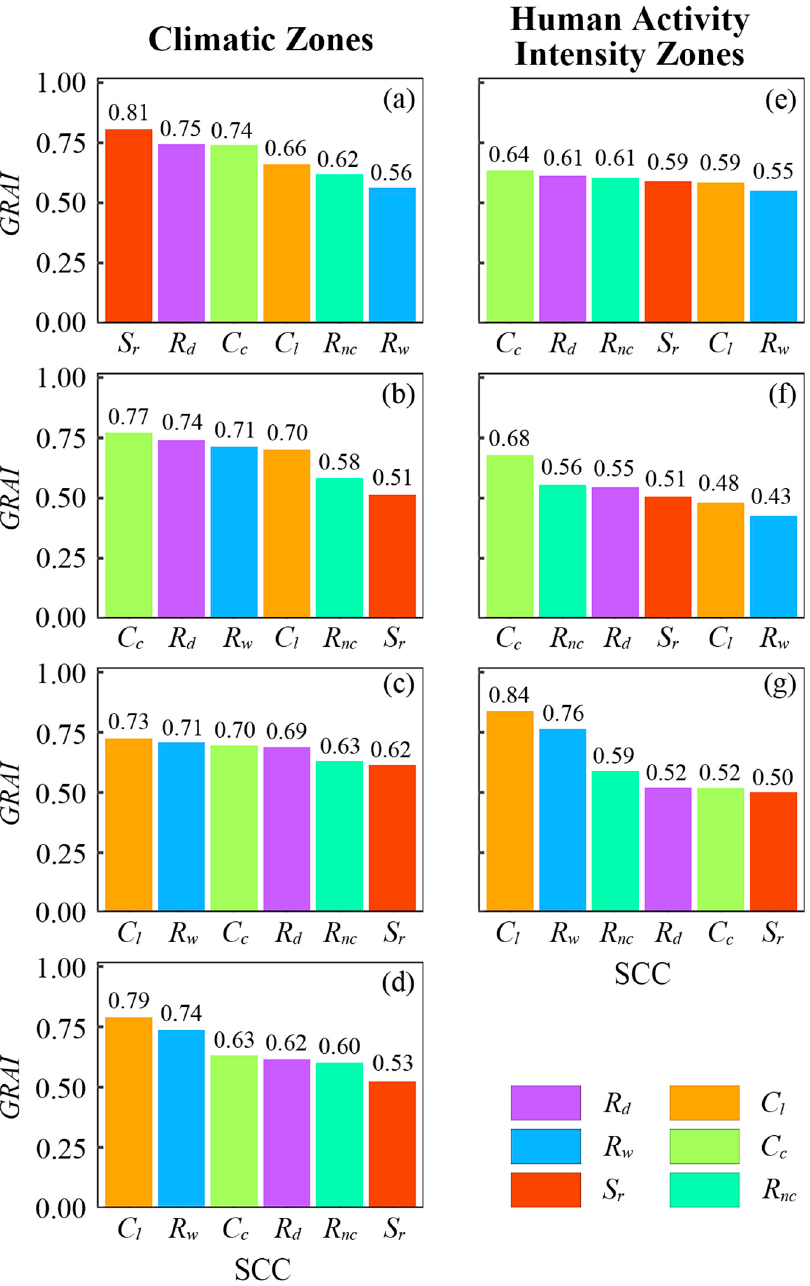
Figure 6. Plots illustrating the grey relational degree index ( GRAI ) in different climatic zones (left panel) and human activity intensity zones (right panel). The subplots in left panel ( a – d ) showed GRAI of six SCCs in humid, semi-humid, semi-arid and arid zones, respectively. The subplots in right panel ( e – g ) showed GRAI of six SCCs in intense, moderate and weak zones, respectively. Table 3. The GRAI between RI and each SCC nationwide.